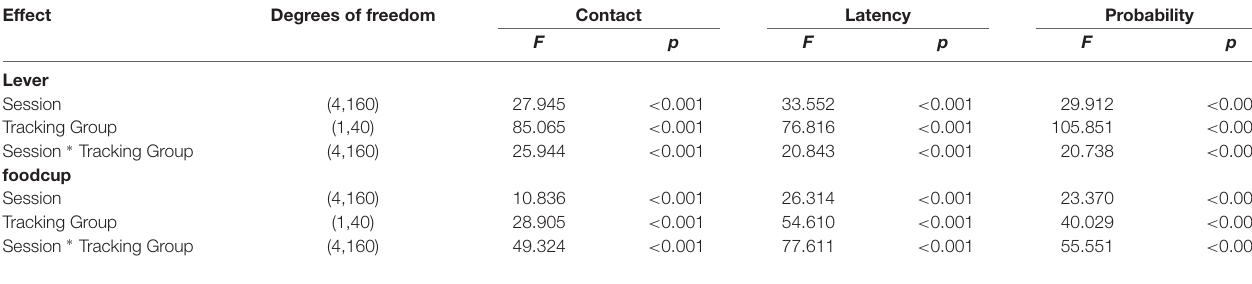
TABLE 1 | Repeated measures analysis of variance (ANOVA) for Pavlovian lever autoshaping across all tracking